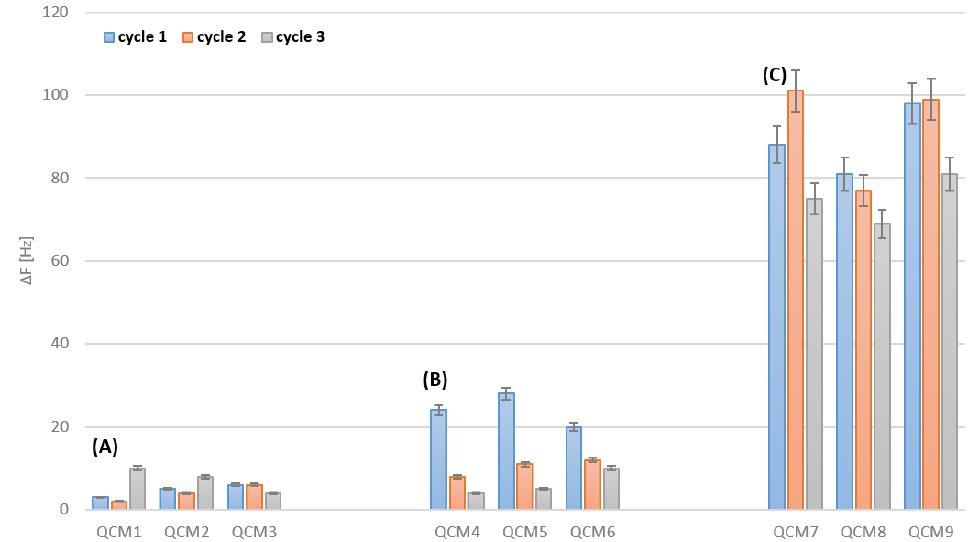
Figure 2. Changes in resonant frequencies [Hz] of bare gold QCM electrodes after regeneration: ( A ) electrochemical (QCM1—hydrochloric acid potential cycling, QCM2—sulphuric acid potential cycling, QCM3—potassium hydroxide potential sweep), ( B ) plasma and ( C ) Piranha cleaning methods. Error bar indicates the calculated standard deviation (n − 3).